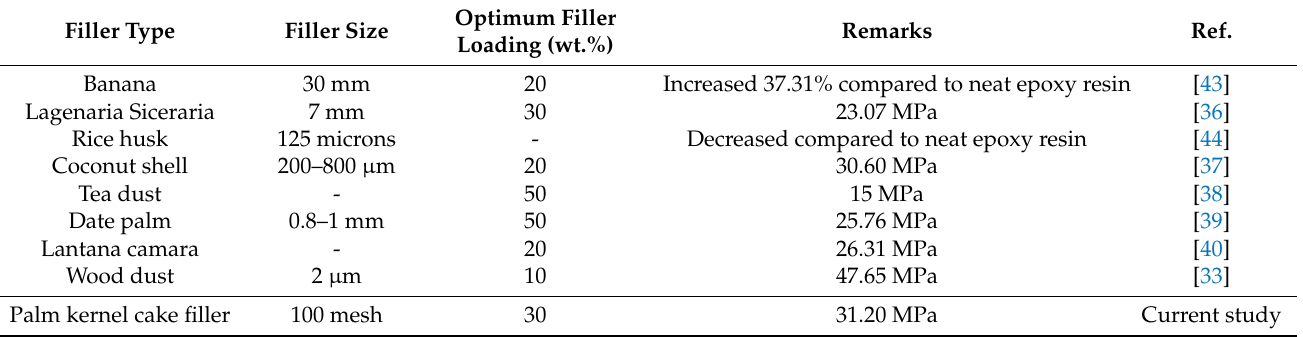
Table 4. Reported previous studies on tensile properties of various filler-reinforced epoxy compo- sites.